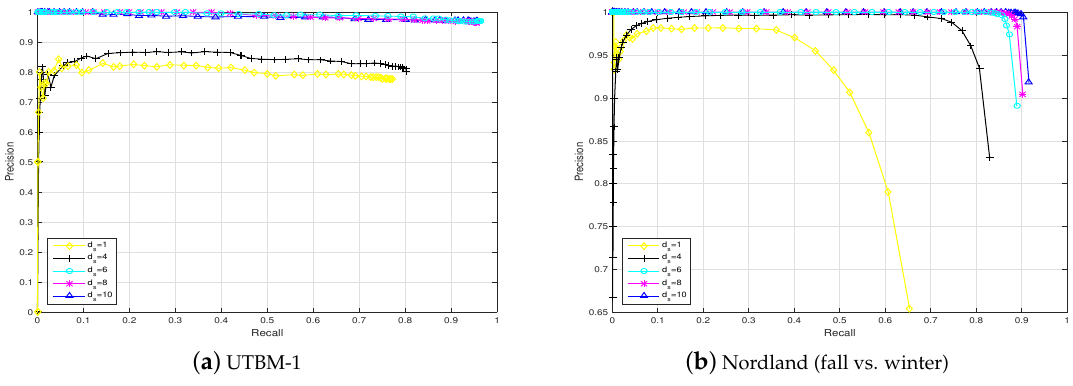
Figure 9. Two examples of a performance comparison of our proposal depending on the image sequence length ( d s ) in the challenging UTBM-1 and Nordland data sets (fall vs. winter). The feature used here is the conv4